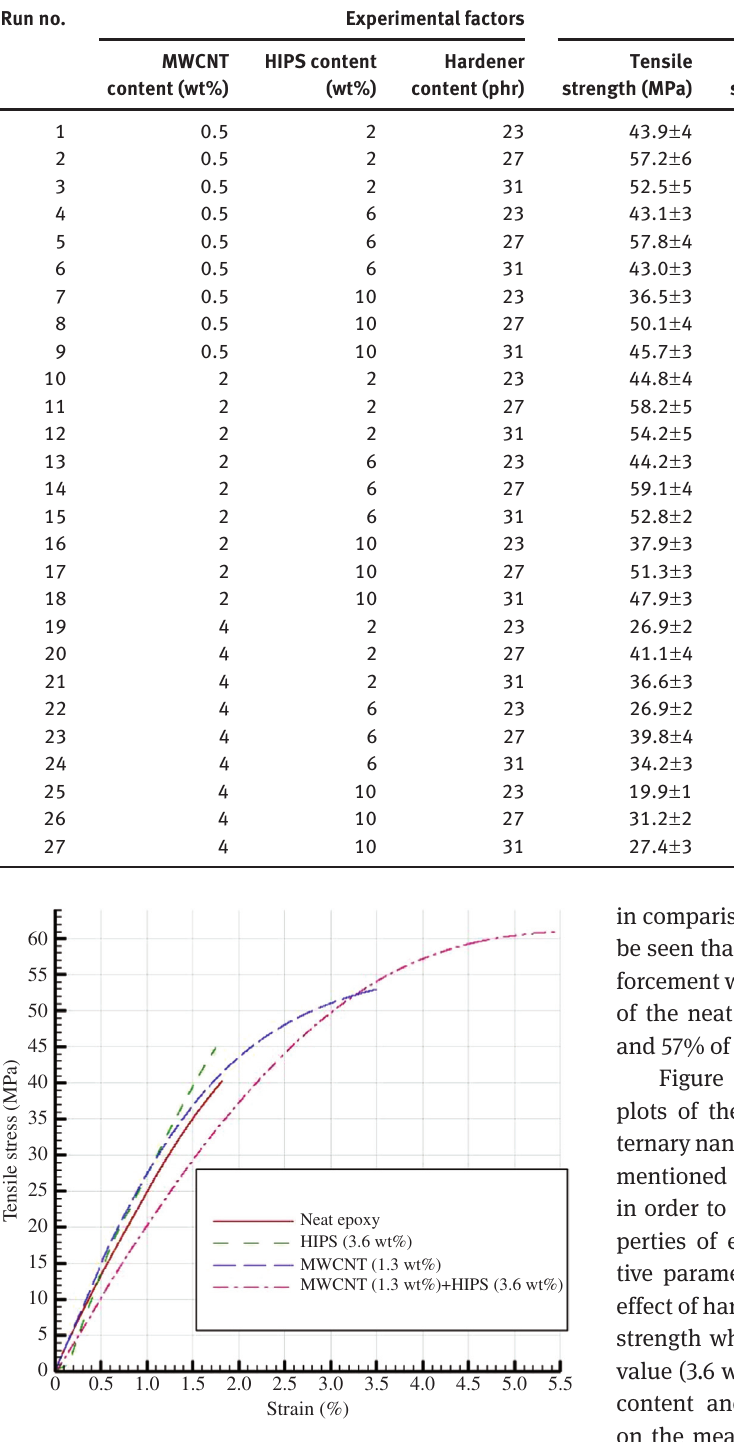
Figure 2 Stress-strain plot of the tensile property. the epoxy/HIPS value (at 3.6 wt% of HIPS) and 16% of the epoxy/MWCNT value (at 1.3 wt% of MWCNT). One obvious note here is that the tensile modulus was reduced a